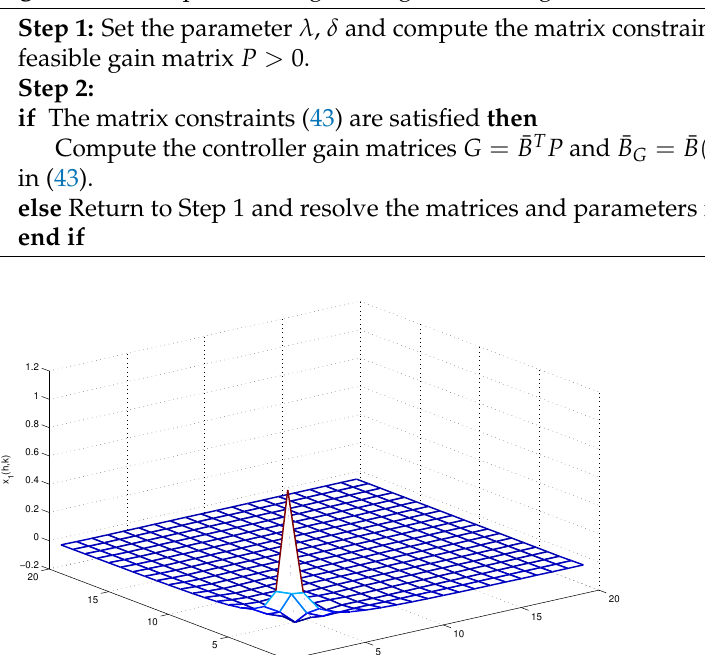
Algorithm 1 Adaptive intelligence algorithm design for Theorem 2.